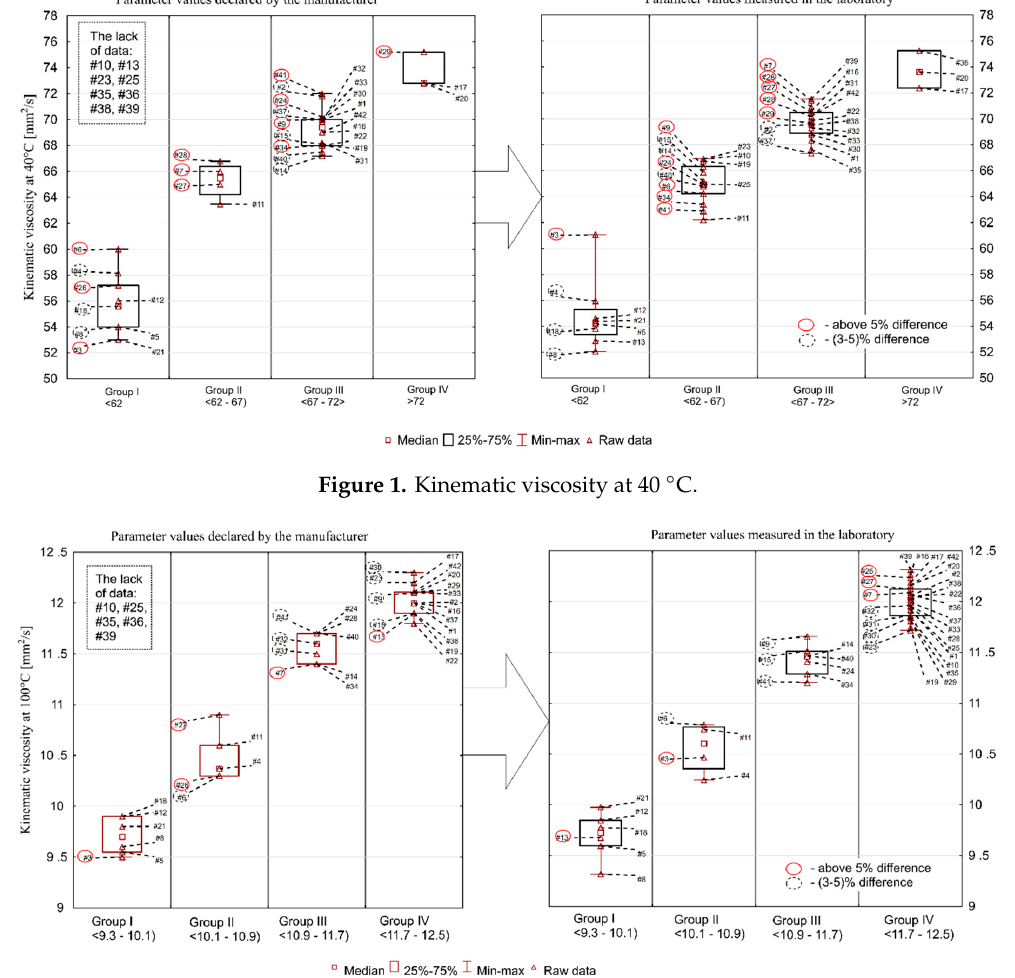
Figure 2. Kinematic viscosity at 100 °C.